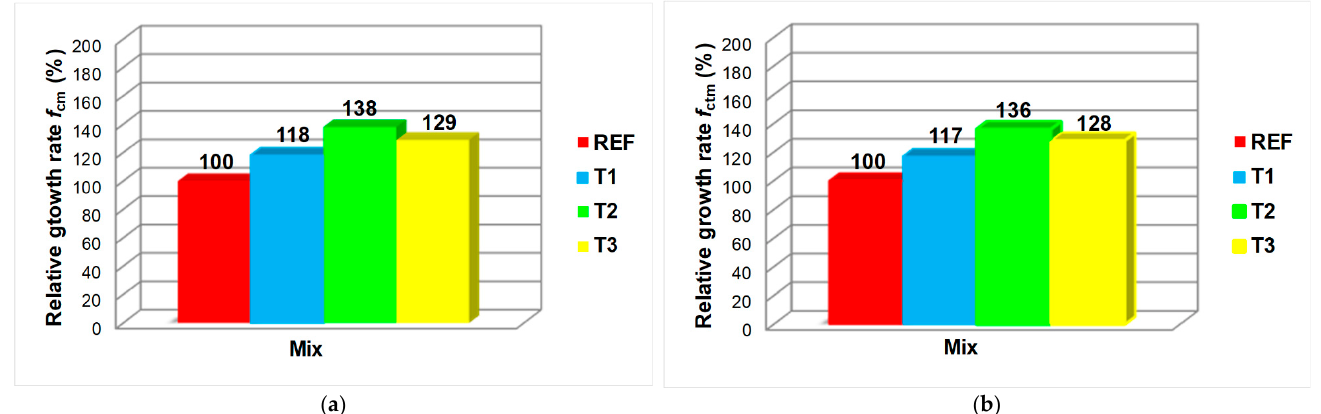
Figure 5. Relative growth rate of compressive strength ( a ) and splitting tensile strength ( b ) of ana-